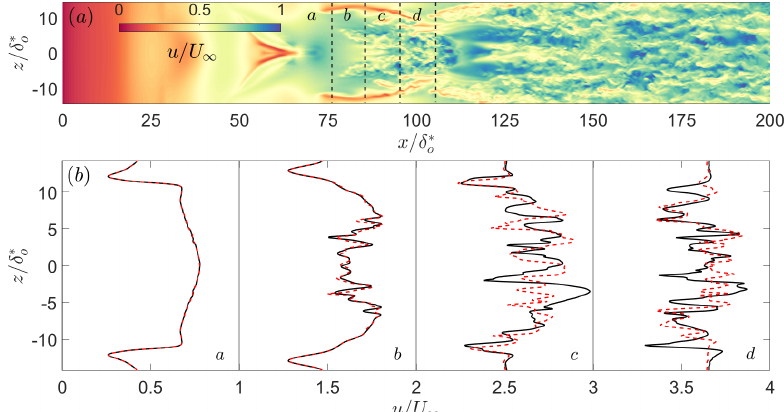
Figure 15. Large step. Instantaneous streamwise velocity in the y wall / δ ∗ o = 1.0 plane. ( a ) Velocity contours; ( b ) velocity profiles at the locations indicated by dashed lines in ( a ). t = t o ; t = t o + T